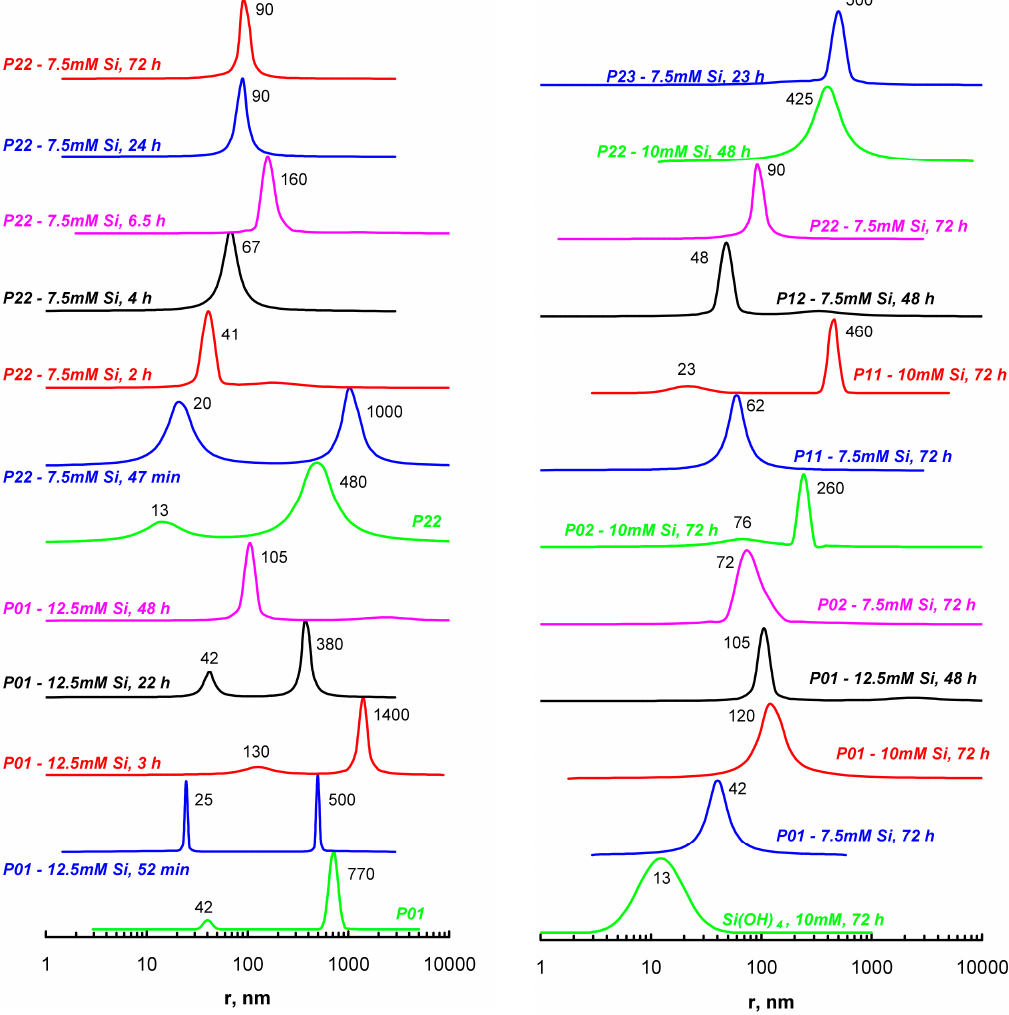
Figure 9. Dynamic light scattering (DLS) data for aqueous solutions of composite particles obtained under silicic acid condensation in the presence of new polymers (0.4 g·L − 1 ) at pH 7.4. Initial silicic acid concentrations, the condensation time, and peak positions are indicated near the curves. The left curves show the typical behavior of particle size values during condensation and the right curves represent the DLS of the resulting composite nanoparticles. Some systems had precipitates after 72 h of the reaction and in these cases earlier data are presented.